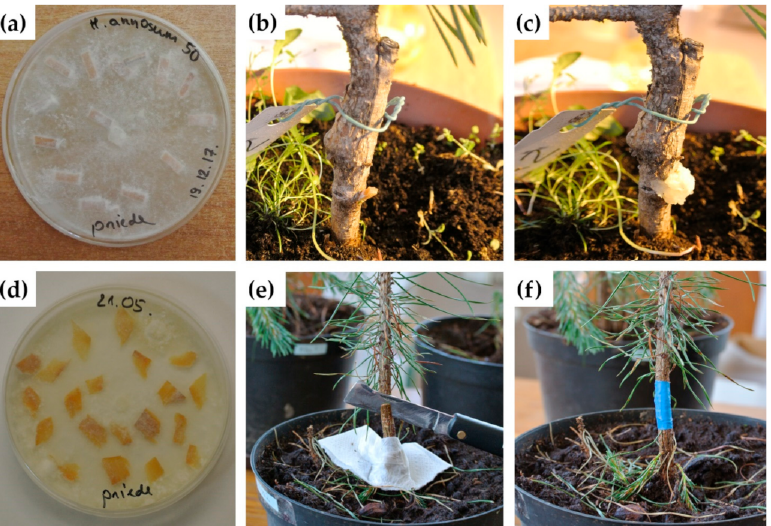
Figure 1. Two different inoculation techniques utilized: ( a – c ) Inoculation of P. sylvestris ramets